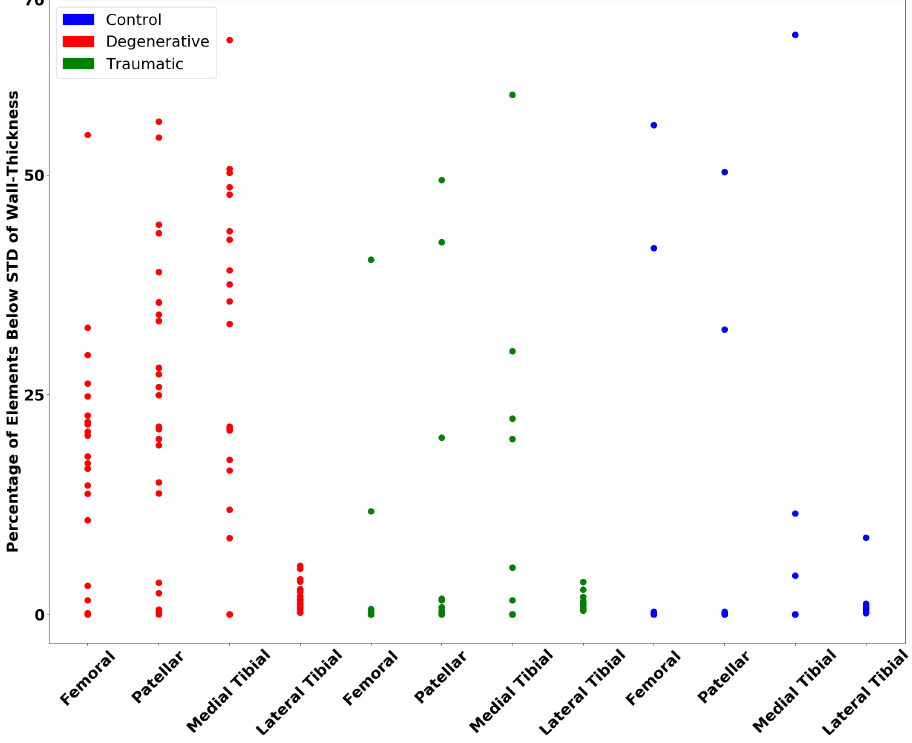
Figure 7. Percentage of elements below a certain standard deviation of the mean, using an STD weight of 0.5 for femoral, patellar and medial tibia cartilages and 0.3 for the lateral tibia cartilage as per Equation